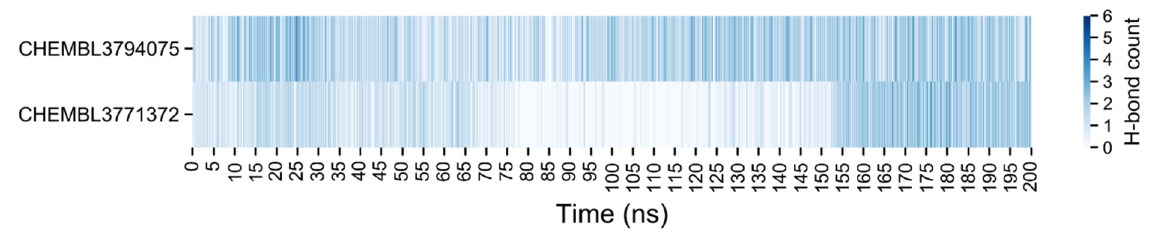
Figure 17. Number of hydrogen bonds between the EZH2 and the ligands, the top from the CHEMBL3771372 and the bottom from the CHEMBL3794075. A detailed plot is shown in Supporting Figures S8 and S9.